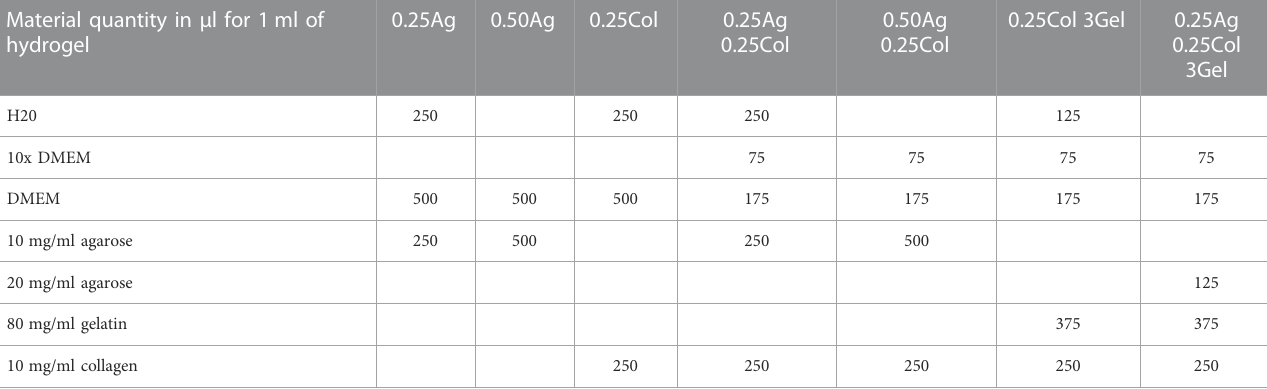
TABLE 3 Mixture ratios for hydrogel blends of agarose, gelatin and collagen I. For experiments containing HepG2 cells, 175 µl DMEM were replaced by a HepG2 stock suspension. Quantities are given in µl. Material quantity in µl for 1 ml of